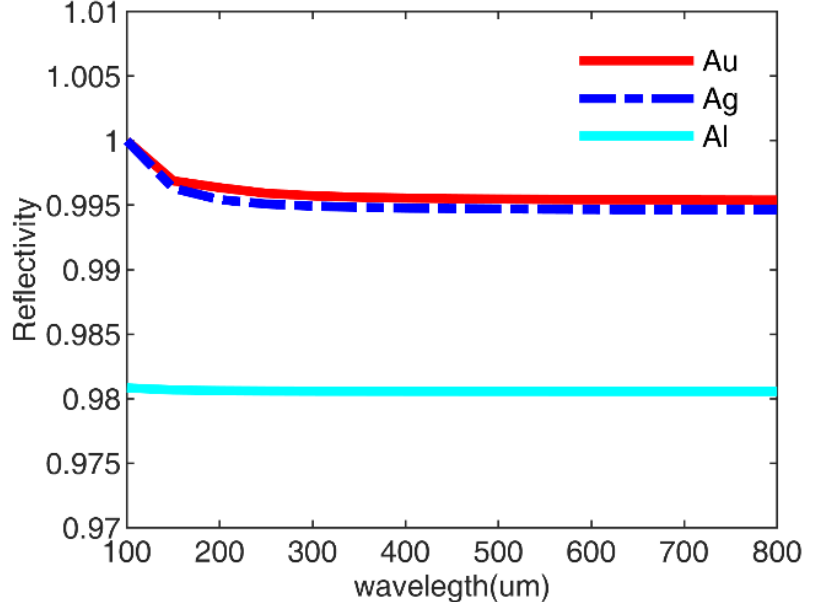
Figure 15. Reflectivity of the bottom metal layer under the different metal. Table 1. Comparisons between the two